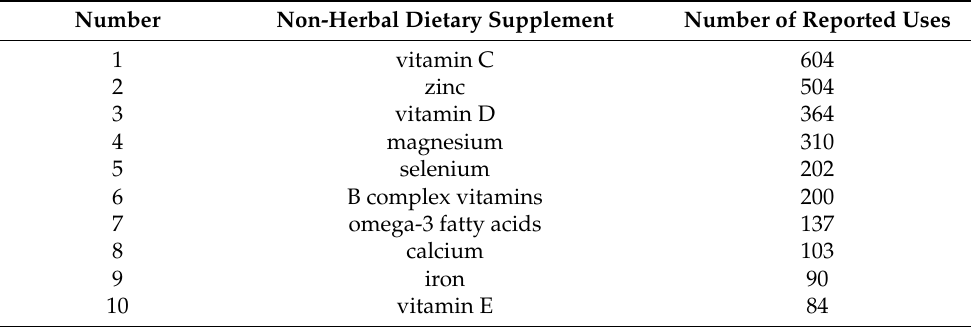
Table 7. List of most frequently used non-herbal dietary